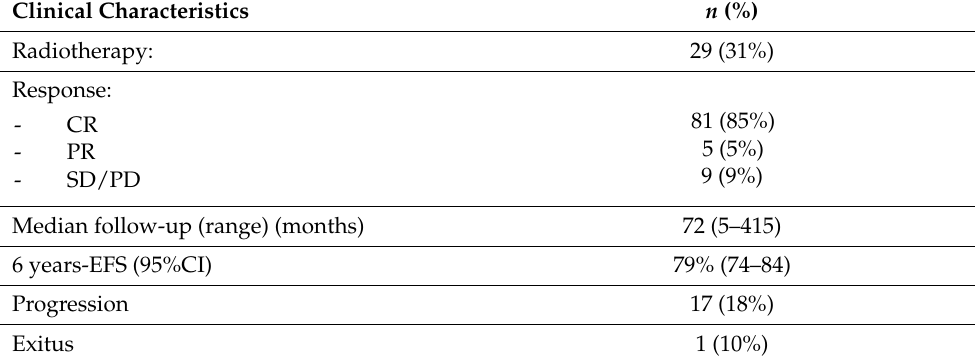
Table 1. Cont . Clinical Characteristics